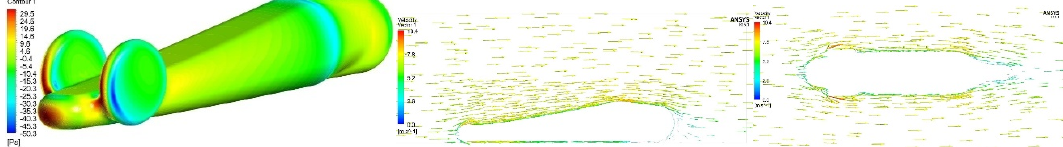
Figure 8. Air resistance simulation for body no. 3.